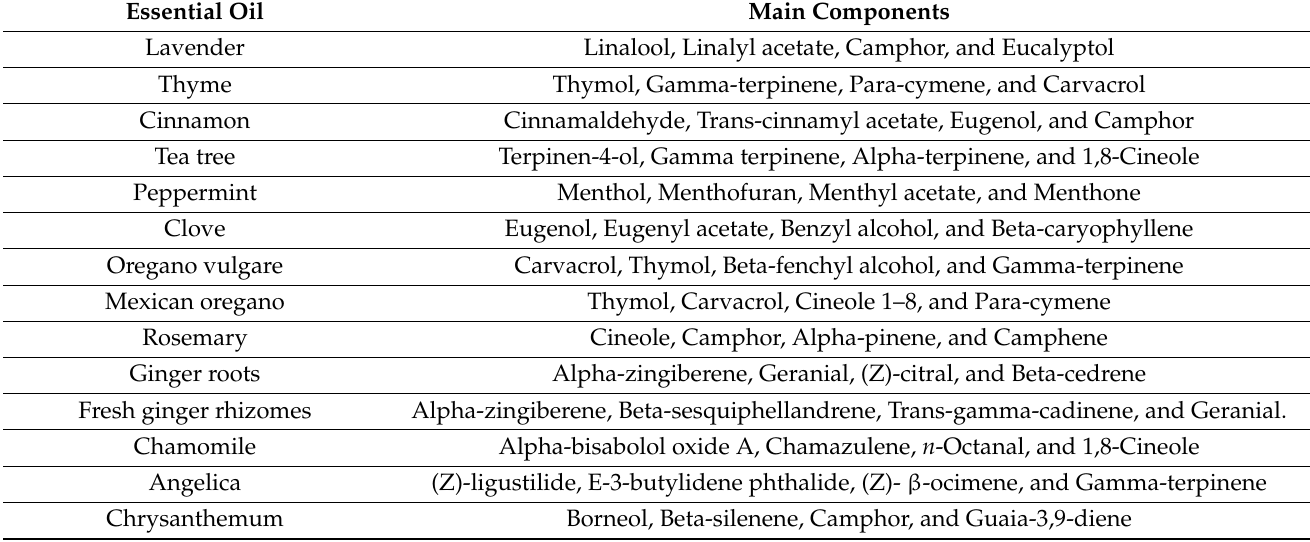
Table 2. Chemical composition of essential oils that have been impregnated with polymeric nanofibers. Main